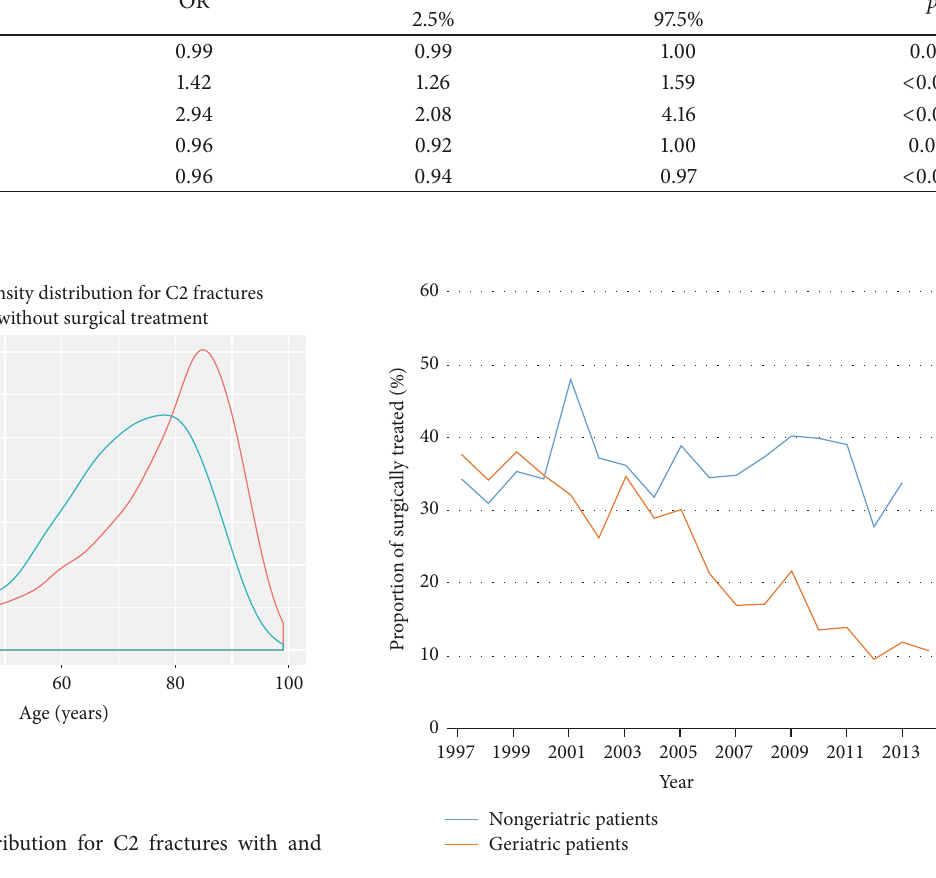
Figure 7: Proportion of surgically treated nongeriatric (blue) and geriatric (orange) patients with C2 fractures between 1997 and